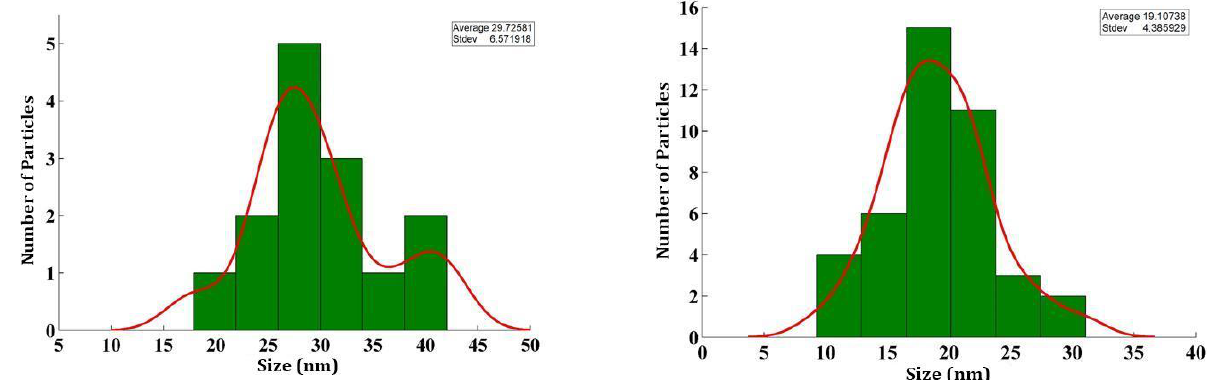
Figure 6. Particle size distribution of Mn catalyst.